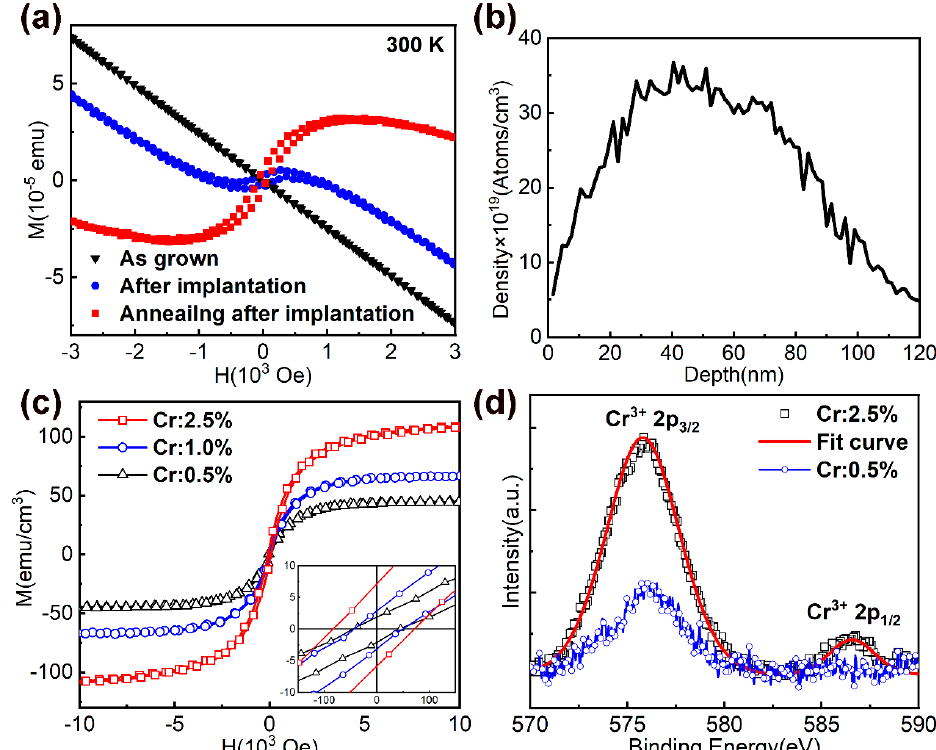
Figure 2. ( a ) Magnetic properties of as-grown InN nanorods and the InN nanorods after implantation (Cr: 2.5%) and the InN nanorods annealing after implantation; ( b ) SRIM simulation of depth distribution of 110 keV Cr + ions with dose of 1.3×10 16 ions/cm 2 ; ( c ) M–H curves for the InN nanorods with different doses of Cr + implantation (Cr: 0.5%, Cr: 1.0%, Cr: 2.5%). Inset shows hysteresis at lower fields; ( d ) XPS spectra of the implanted InN nanorods.